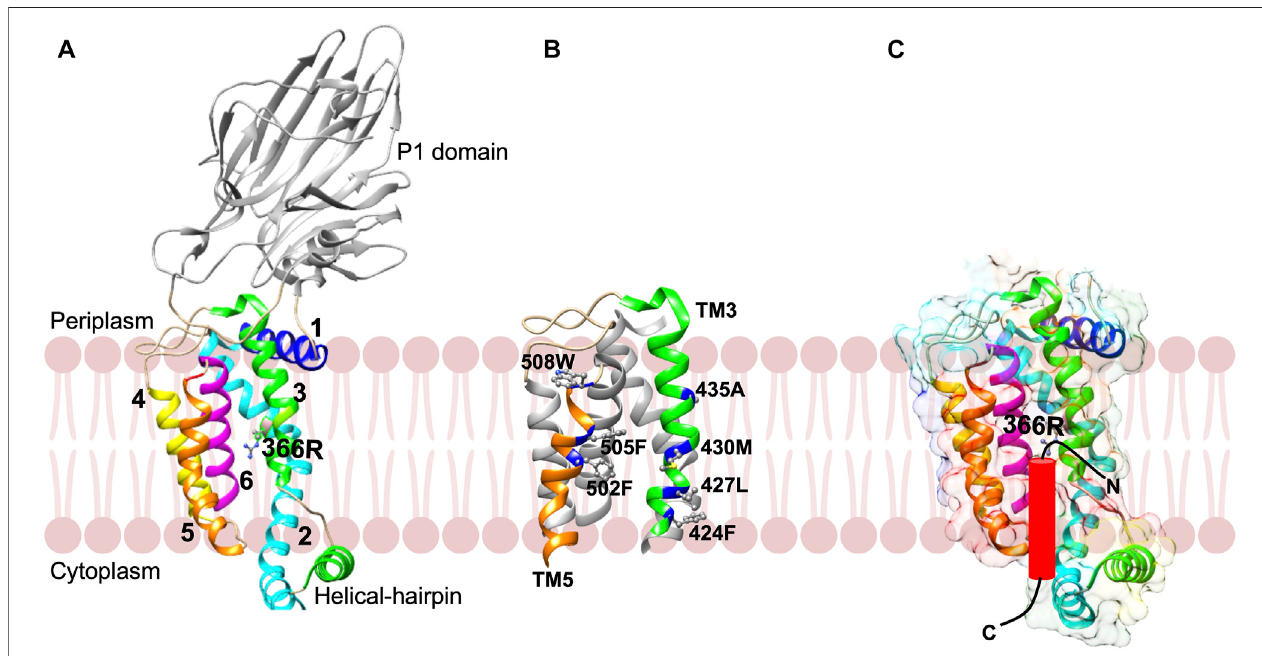
FIGURE 8 | The YidC insertase [adapted from Kumazaki et al. (2014b) PDB: 3WVF]. (A) The E. coli YidC has a large periplasmic domain, a coiled cytoplasmic domain,andaconservedcoreregioncomprisingof5 TMhelices(TMs2 – 6)thatformahydrophilicgrooveopentothecytoplasmandlipidbilayer.Thehydrophilicgroove has a strictly conserved arginine that helps to keep the region hydrated. (B) A close-up view of the greasy slide (TM3 and TM5) that contacts the TM region of YidC substrates during insertion. The residues that contact the substrate TM segment (s) are indicated in dark blue. (C) During membrane insertion of the Pf3 coat, the TM segment moves up the greasy slide with the N-tail region captured transiently in the hydrophilic groove. The periplasmic domain of YidC is omitted in (B,C) .